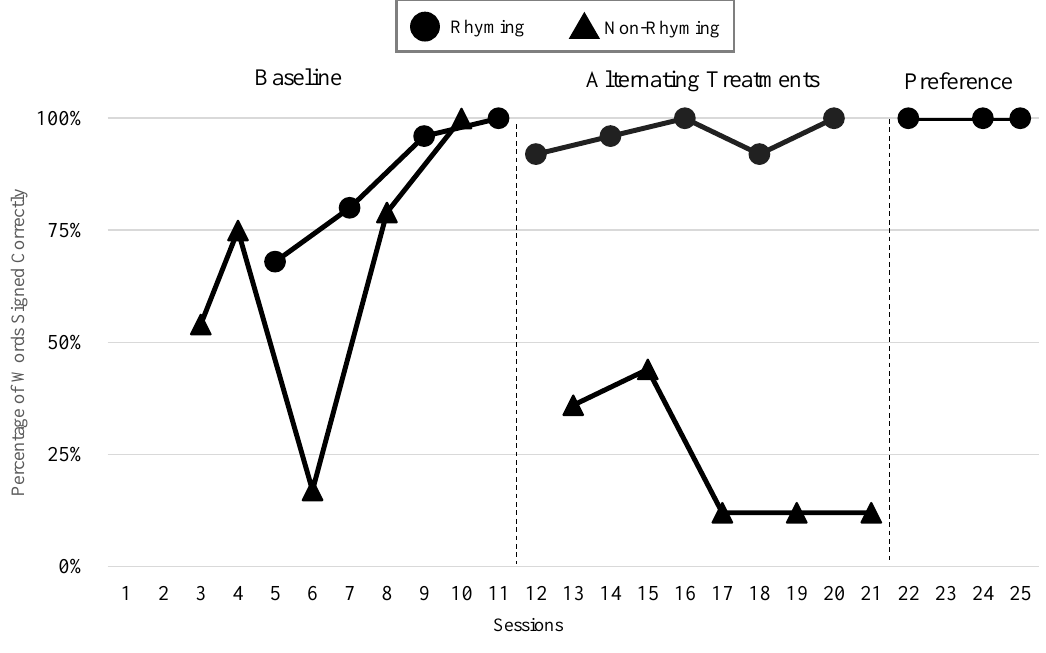
Figure 12. Giada’s Percentage of Words Signed in the Correct Order in Recitation.